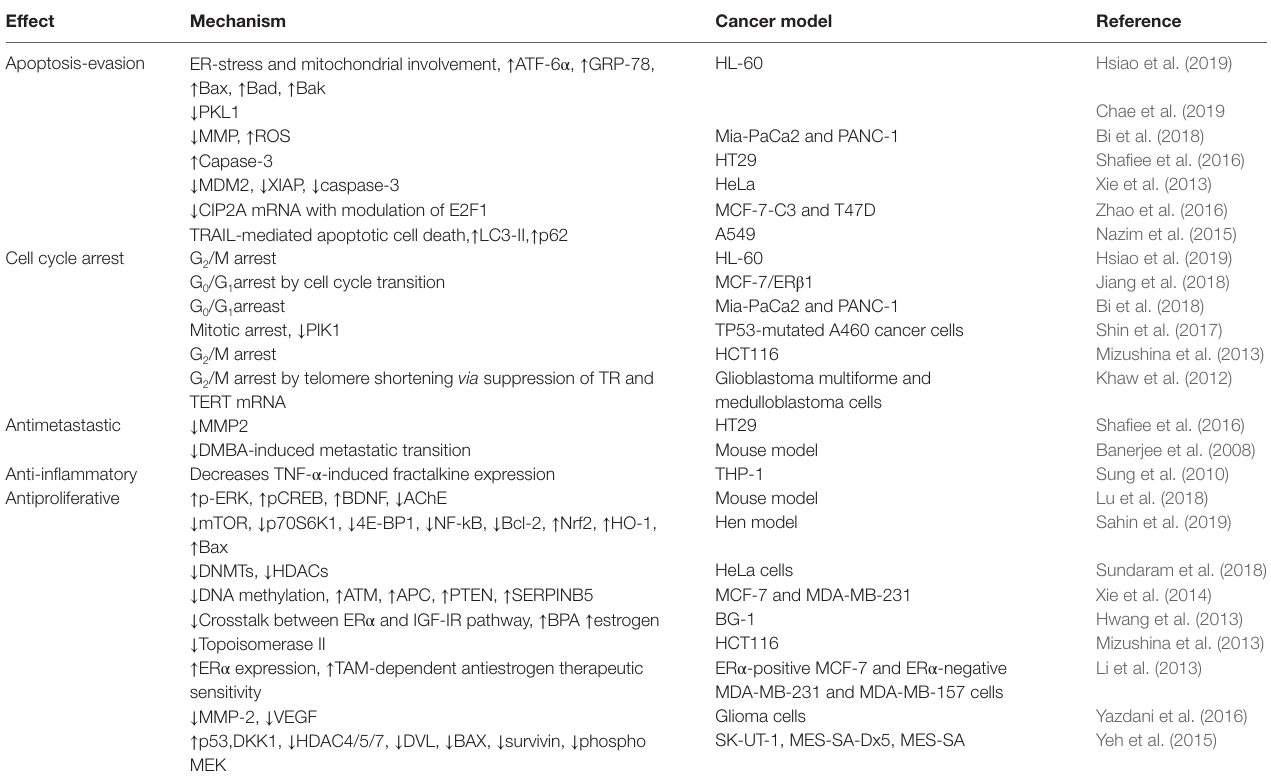
TABLe 1 | Anticancer molecular mechanism of